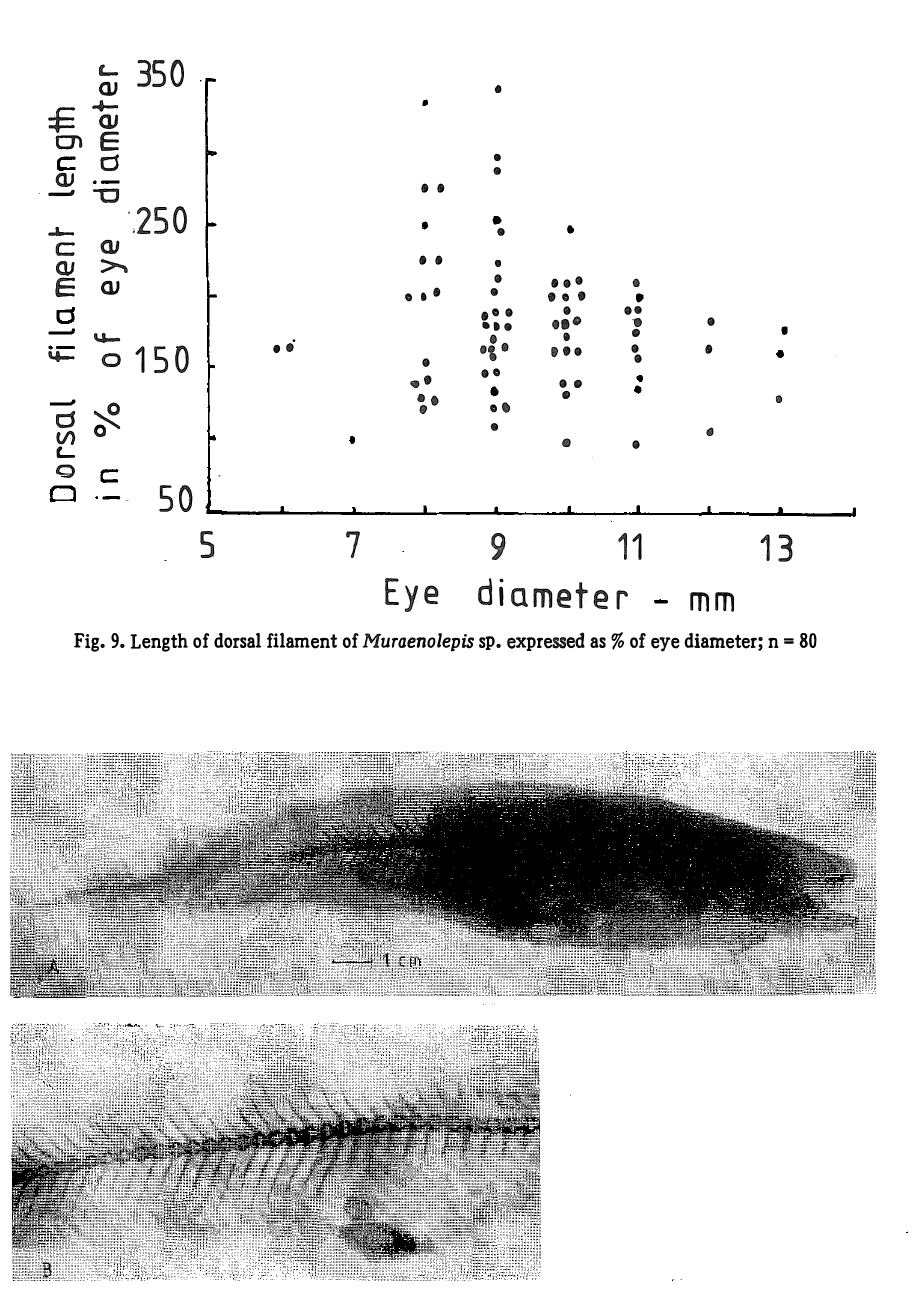
Fig . 10. R o en t g en o g ra m o f M u r a e no l e p i s s p . skeleton; A - f i s h a s a whole; B - a se c t ion en la rg